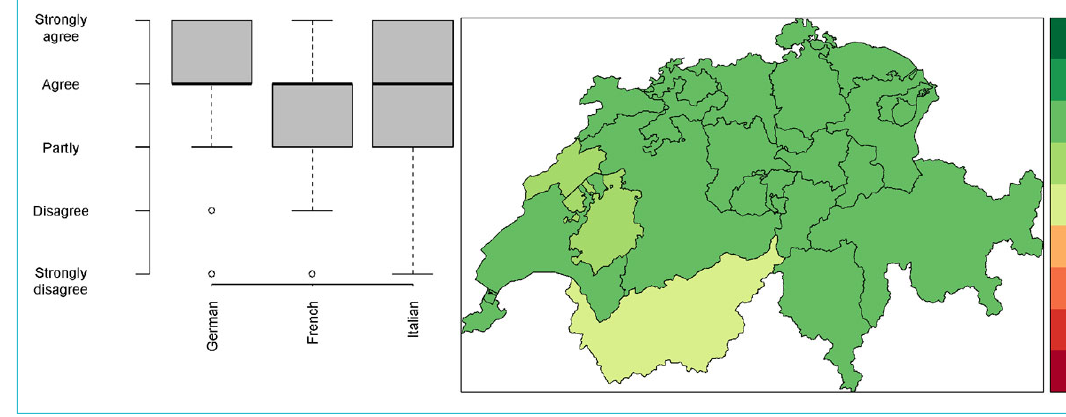
Figure 1: Boxplot (left) and map (right) of satisfaction with the access to diagnostic assessment possibilities for patients with cognitive impair- ment across language region. The map displays the median agreement across cantons. ++ = strongly agree (satisfied), +/- partially agree, -- strongly disagree (not